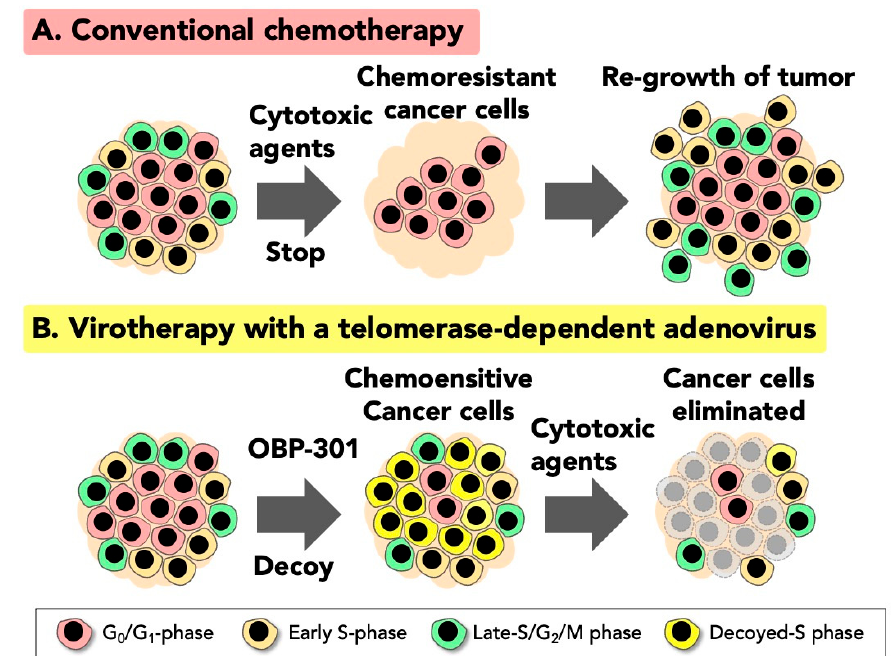
Figure 2. Fluorescence ubiquitination cell cycle indicator (FUCCI) imaging demonstrates that an oncolytic adenovirus decoys quiescent cancer stem cells to cycle and become sensitive to chemotherapy. ( A ) Conventional chemotherapy only kills proliferating cancer cells in the S/G 2 /M phase. In contrast, chemotherapy has little efficacy against quiescent cancer cells in G 0 /G 1 phase. Resistant quiescent cancer cells restart proliferation after chemotherapy. ( B ) Oncolytic adenovirus, OBP-301, decoys quiescent cancer cells to cycle to early S-phase which makes them sensitive to chemotherapy. Conventional cytotoxic chemotherapy has great efficacy against decoyed cancer cells in